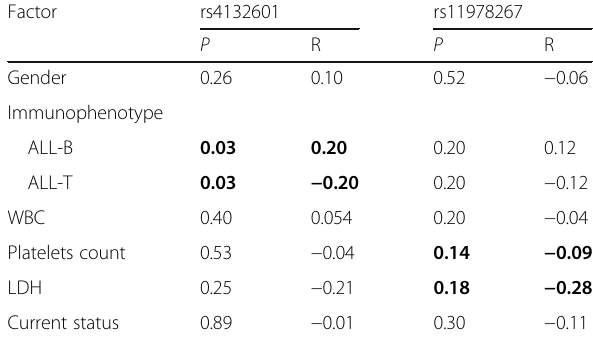
Table 4 Pearson correlations of IKZF1 studied